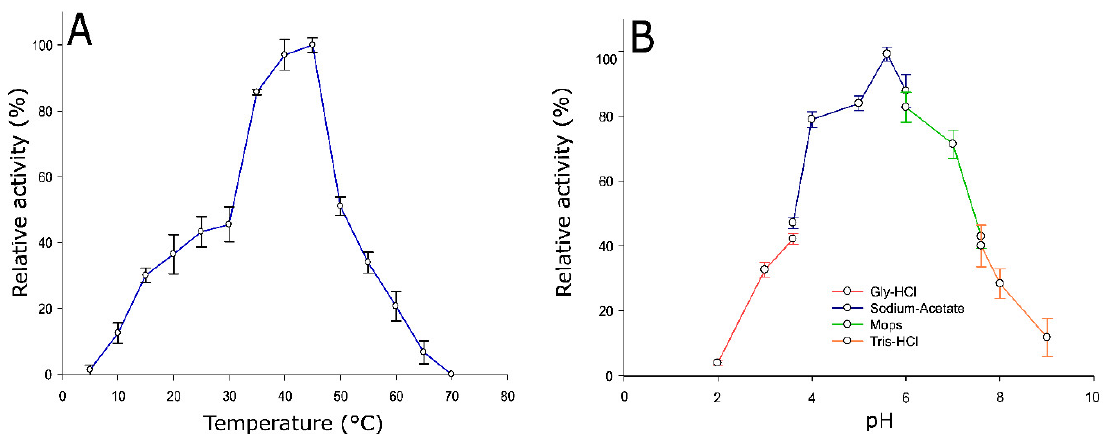
Figure 4. Effect of temperature and pH on Pho16B activity. ( A ) Temperature profile of Pho16B enzymatic activity. ( B ) pH profile of Pho16B enzymatic activity. All measurements were performed in triplicate. Specific activity values are expressed as percentages of the highest relative activity: 8.78 and 4.3 U/mg, for A and B, respectively.